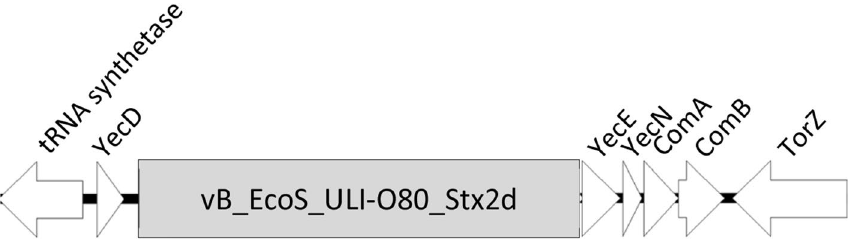
Figure 4. Insertion site yecE of the three transduced strains. tRNA synthetase: Aspartyl-tRNA synthetase, YecD: isochorismatase-family protein, YecN: Inner membrane protein YecN, ComA: Carboxy-S-adenosyl- l-methionine synthase, ComB: tRNA ho5U(34) carboxymethyltransferase, Tor-Z: Trimethylamine- N -oxide